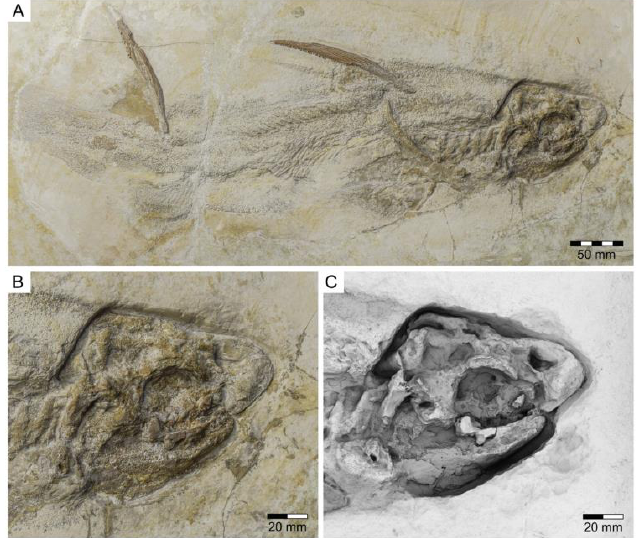
Figure 10. Articulated skeleton of † Hybodus fraasi Brown, 1900 [172] from the early Tithonian of Solnhofen. ( A ) Complete specimen (SNSB-BSPG 1899 I 2, holotype). ( B ) Close-up view of head. ( C ) Ambient occlusion photogrammetric model of head (courtesy of Christoph Kettler).